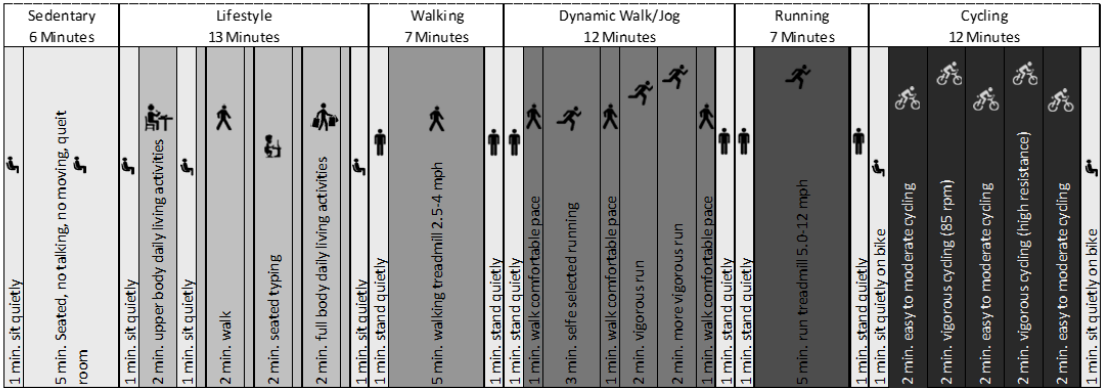
Figure 2. Summary of Consumer Technology Association standards for heart rate testing (5).